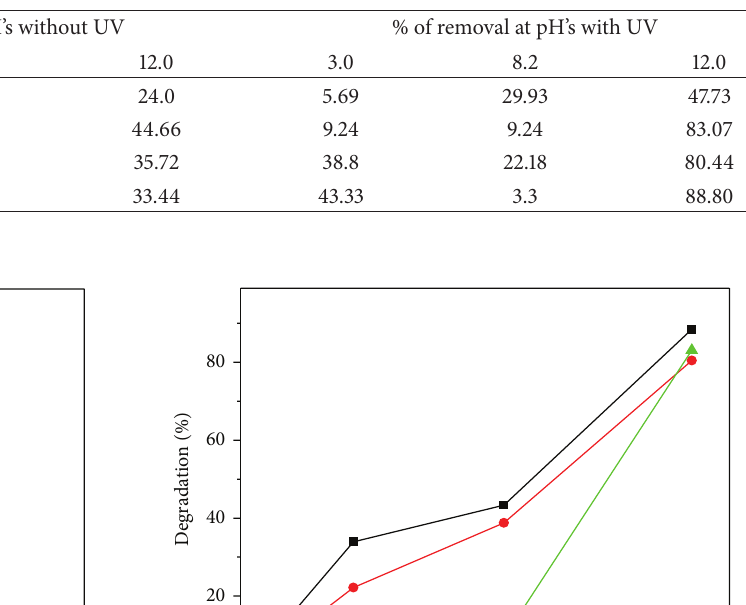
Table 3: Decolorization of dyes using Cu(II), Ni(II), and Co(II) complexes.